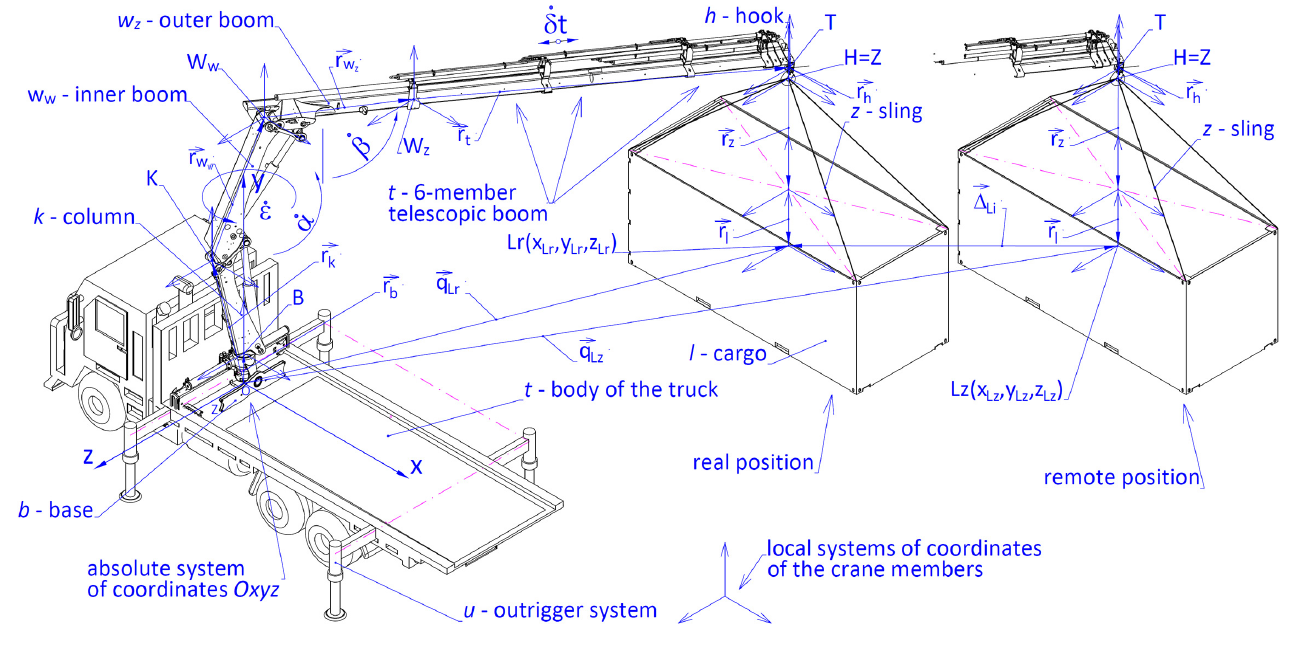
−→ ∆ kr —closing link determining the −→ r k —vector determining